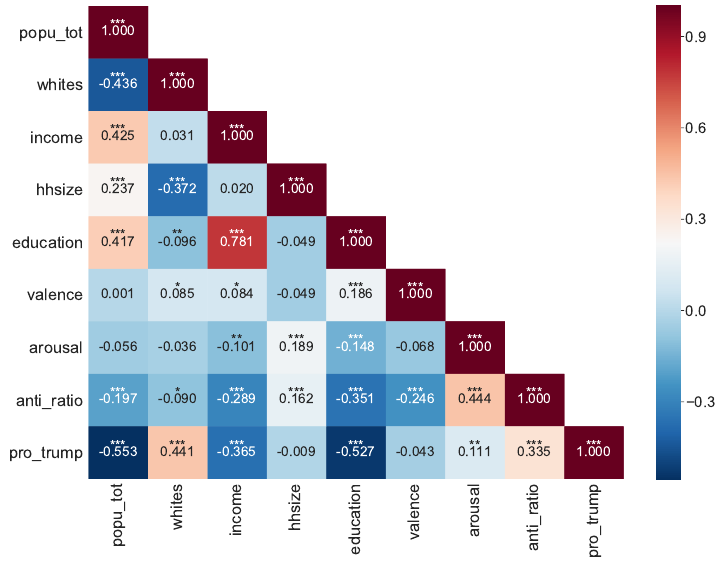
Figure 2. Correlations between socioeconomic variables, political ideology, sentiment, and anti- science attitudes. The last two variables were measured from social media messages. All variables represent averages aggregated per county. Statistically significant correlations are marked by asterisks (***: <0.1%, **: <1%, *: